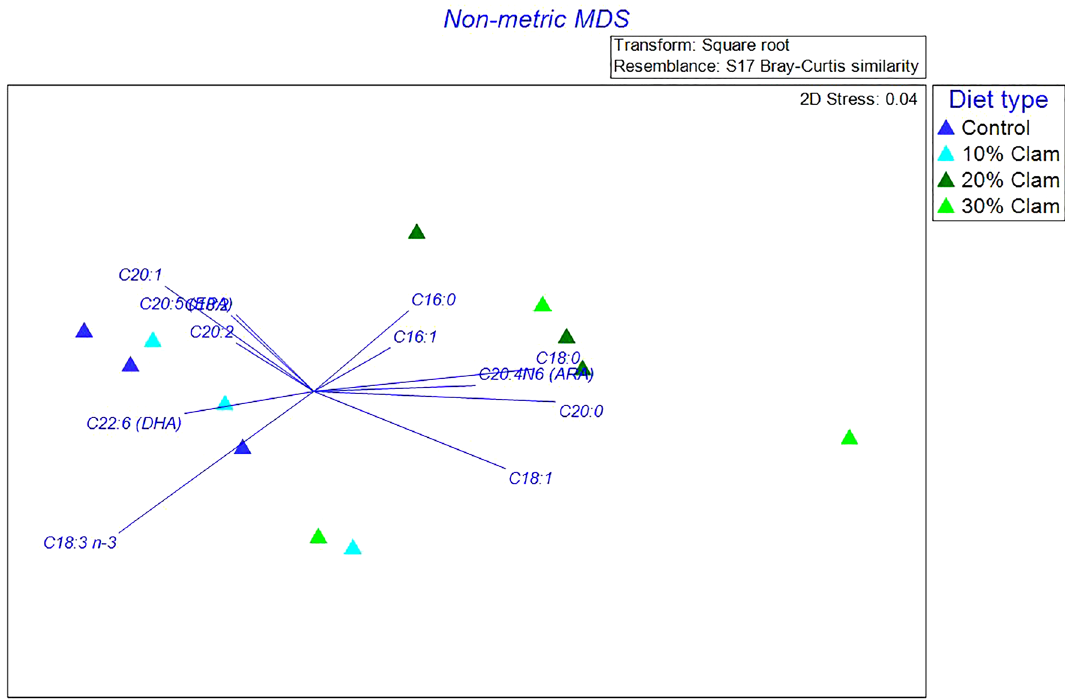
Figure 3. Non-metric multidimensional scaling (n-MDS) of the Bray–Curtis similarity matrix based on the relative abundance of fatty acid profiles associated with diets fed to Florida pompano ( Trachinotus carolinus ) juveniles; control diet (dark blue triangles); 10% clam meal (CM) diet (light blue triangles); 20% CM diet (dark green triangles); and 30% CM diet (light green triangles). The n-MDS shows two main clusters: 1st cluster regroups diet samples from control and 10% CM; and the second cluster regroups diet samples from 20 and 30% CM diets. The arrows length and direction represent the fatty acids responsible for most of the